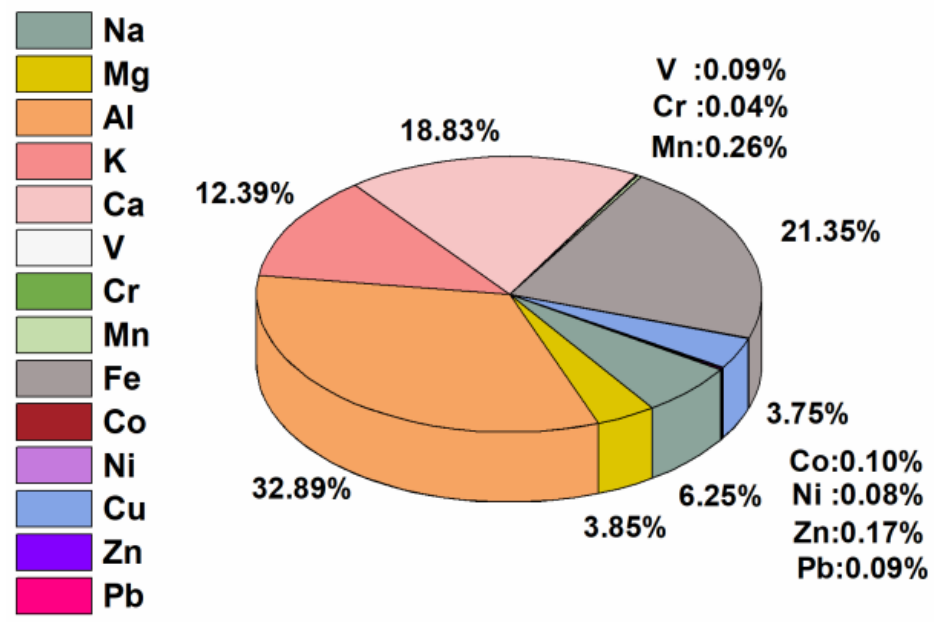
Figure 7. Proportion for the mass concentration of trace elements in PM in Lhasa. Compared with other cities in China (Table A1), the mass concentrations of Mg, K, Mn, Cr, Ni, and Zn in PM 3 were lower than the representative locations of Sichuan, Beijing − Tianjin − Hebei region, the Yangtze River Delta, and northern industrial amounts of Cu in other 3